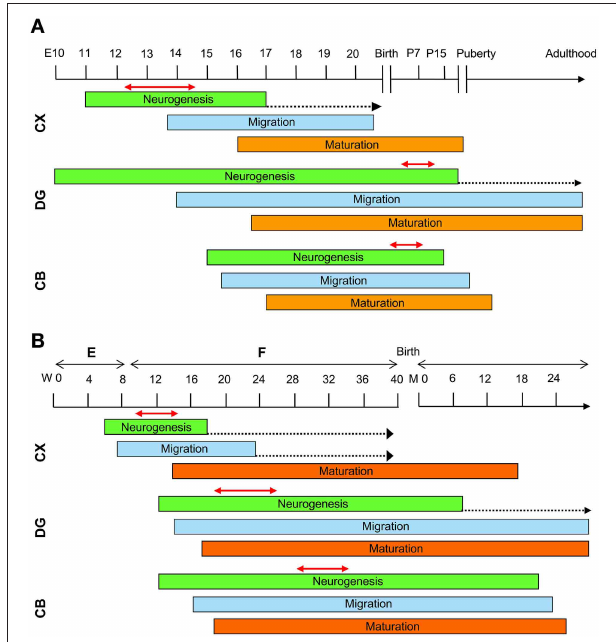
FIGURE 4 | Schematic representation of the timeline of brain development. Timeline of mouse (A) and human (B) brain development. See text for explanations. The dotted arrows indicate a reduction in the rate of neurogenesis. The double-headed red arrows delineate the period of maximum neurogenesis in the different brain regions of the mouse and human brain. Abbreviations: CB, cerebellum; CX, neocortex; DG, dentate gyrys; E, embryonic; F, fetal; M, month; P, post-natal; W,